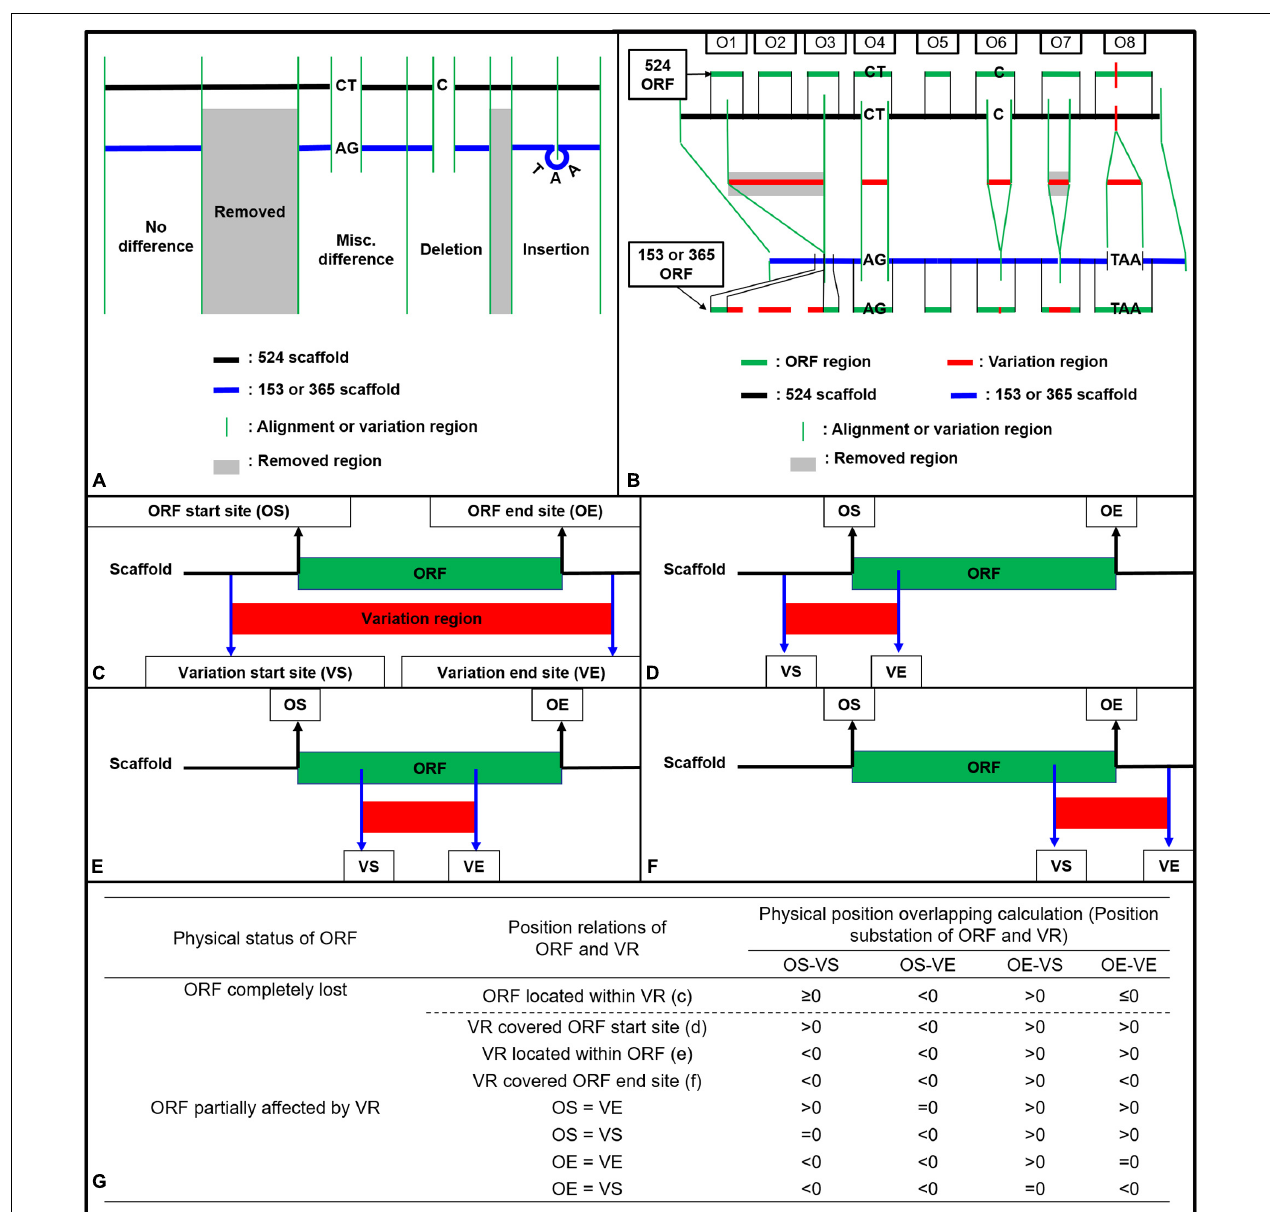
FIGURE 1 | Strategy illustration (A,B) and calculation method (C–G) used for ORF variation identification in strains Coll-153 and Coll-365 when compared to strain Coll-524. (A) Variations were generated after reads mapping of Coll-153 or Coll-365 to Coll-524. The mapping could result in four types of variations (Removed, Misc. Difference, Deletion, and Insertion). (B) ORF regions of Coll-524 were compared to variation regions to find the overlapping. An ORF with the overlapped region indicated that this ORF is varied between the two strains. (C–F) Calculation methods used to identified all potential position relations between an ORF and variation regions. (G) Calculation for position difference to identify ORF variation types, removed or partial differences. VR, variation region; OS, ORF start site; OE, ORF end site; VS, variation start site; VE, variation end